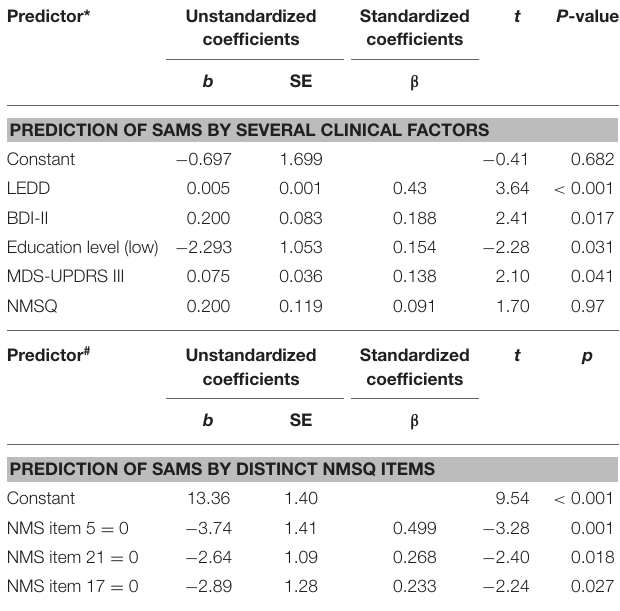
adherence to medication score (SAMS).